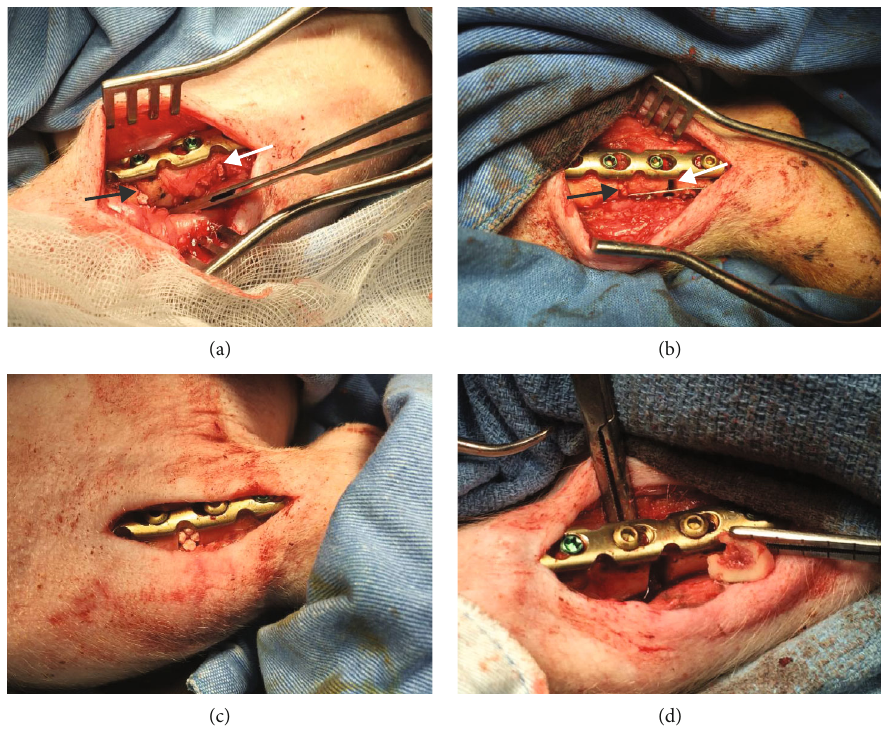
Figure 2: Models of defects C/A1, C/A2, B1, and B2 and photography. (a) The Tibia 1 has control defect C (black arrow) with stripped periosteum whereas the treatment defect A1 (white arrow) with preserved periosteum. Both defects C and A1 have tricalcium-phosphate impacted. (b) The Tibia 2 has control defect C (black arrow) impacted with tricalcium phosphate, and treatment defect A2 (white arrow) without any implantation. In this group, the length of trimmed periosteum was totally 70mm for two lesions (overlapping 20mm). (c) The Tibia 3 has periosteum-stripped defect B1 with tricalcium phosphate impacted followed by injection of human mesenchymal stem cells. (d) The Tibia 4 has periosteum-stripped defect B2 without tricalcium phosphate. Human mesenchymal stem cells are then loaded into the empty space of defect B2. Table 1: The characteristics of